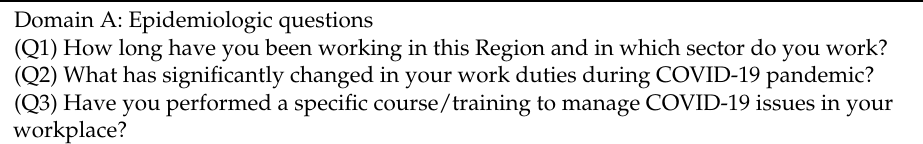
Table 1. Online questionnaire aimed at evaluating epidemiological data, psychological distress and work environmental factors in physical therapists involved in the C.A.L.A.B.R.I.A. study.